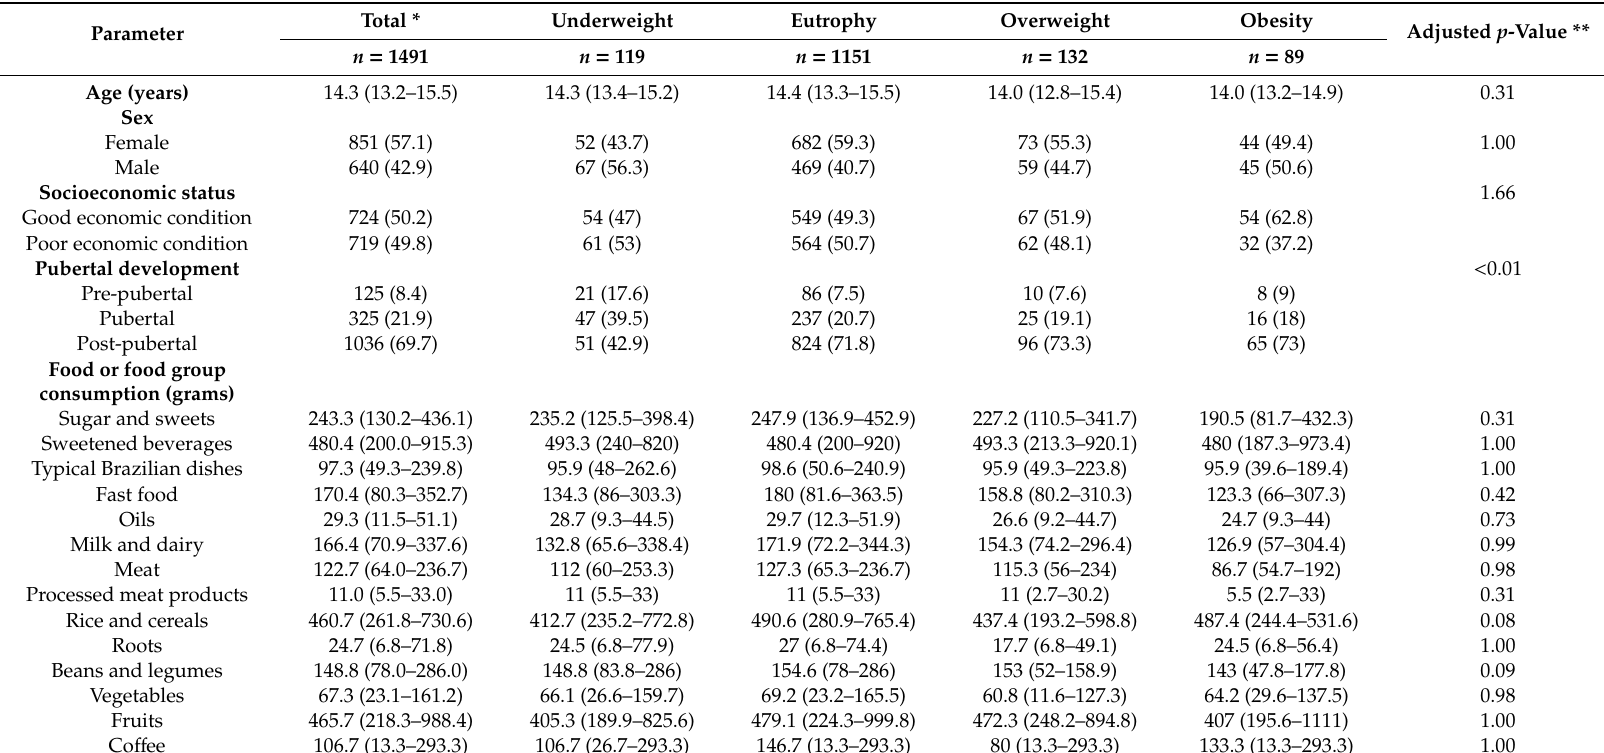
Table 3. Factors associated with the distinct anthropometric